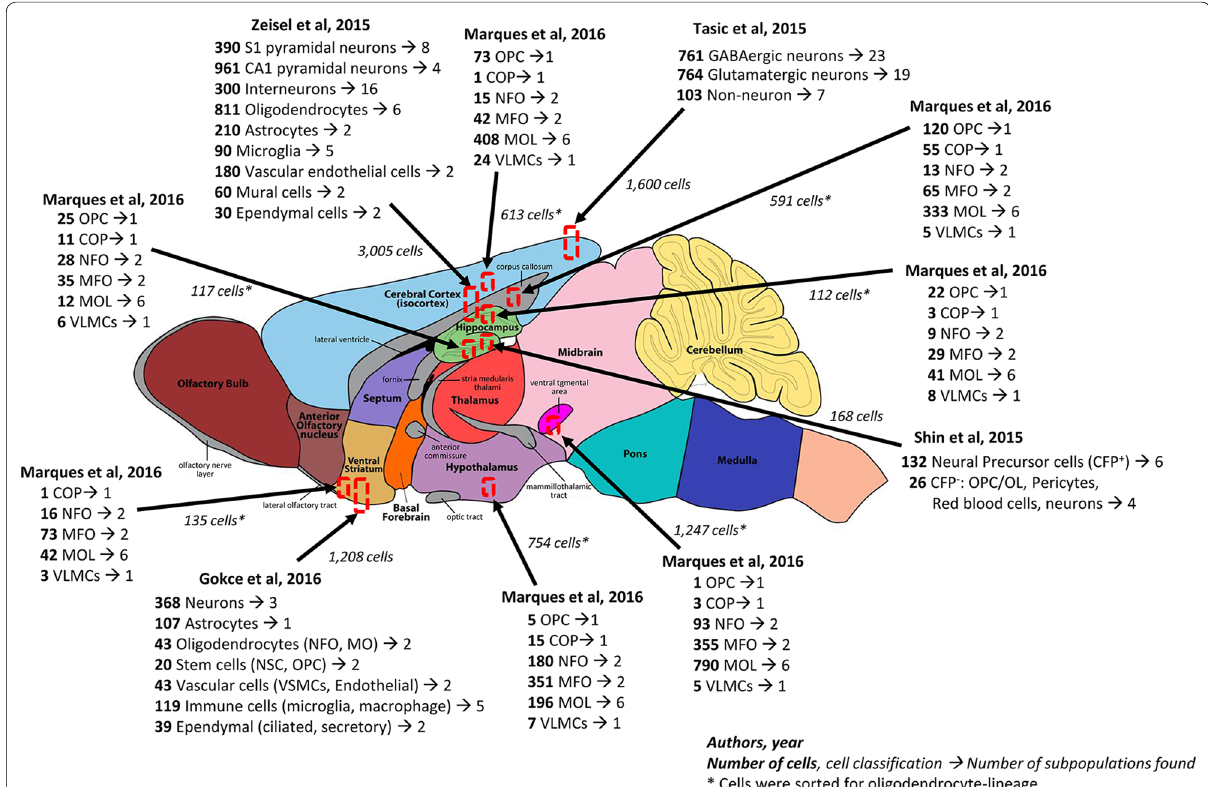
Fig. 1 Selected relevant scRNA‑seq studies revealing brain heterogeneity. Recent high throughput brain scRNA‑seq studies indicate that mouse brain is composed of a large diversity of specialized cell subpopulations. Arrows indicate the sample collection region and the number of isolated cells. The numbers to the left represent the quantity of cells belonging to each global cell type. The numbers to the right represent the quantity of sub‑ populations found within each global cell type. Asterisks indicate cells were enriched for oligodendrocyte‑lineage. Brain model schematic obtained from GENSAT (Gene Expression Nervous System Atlas) [120,